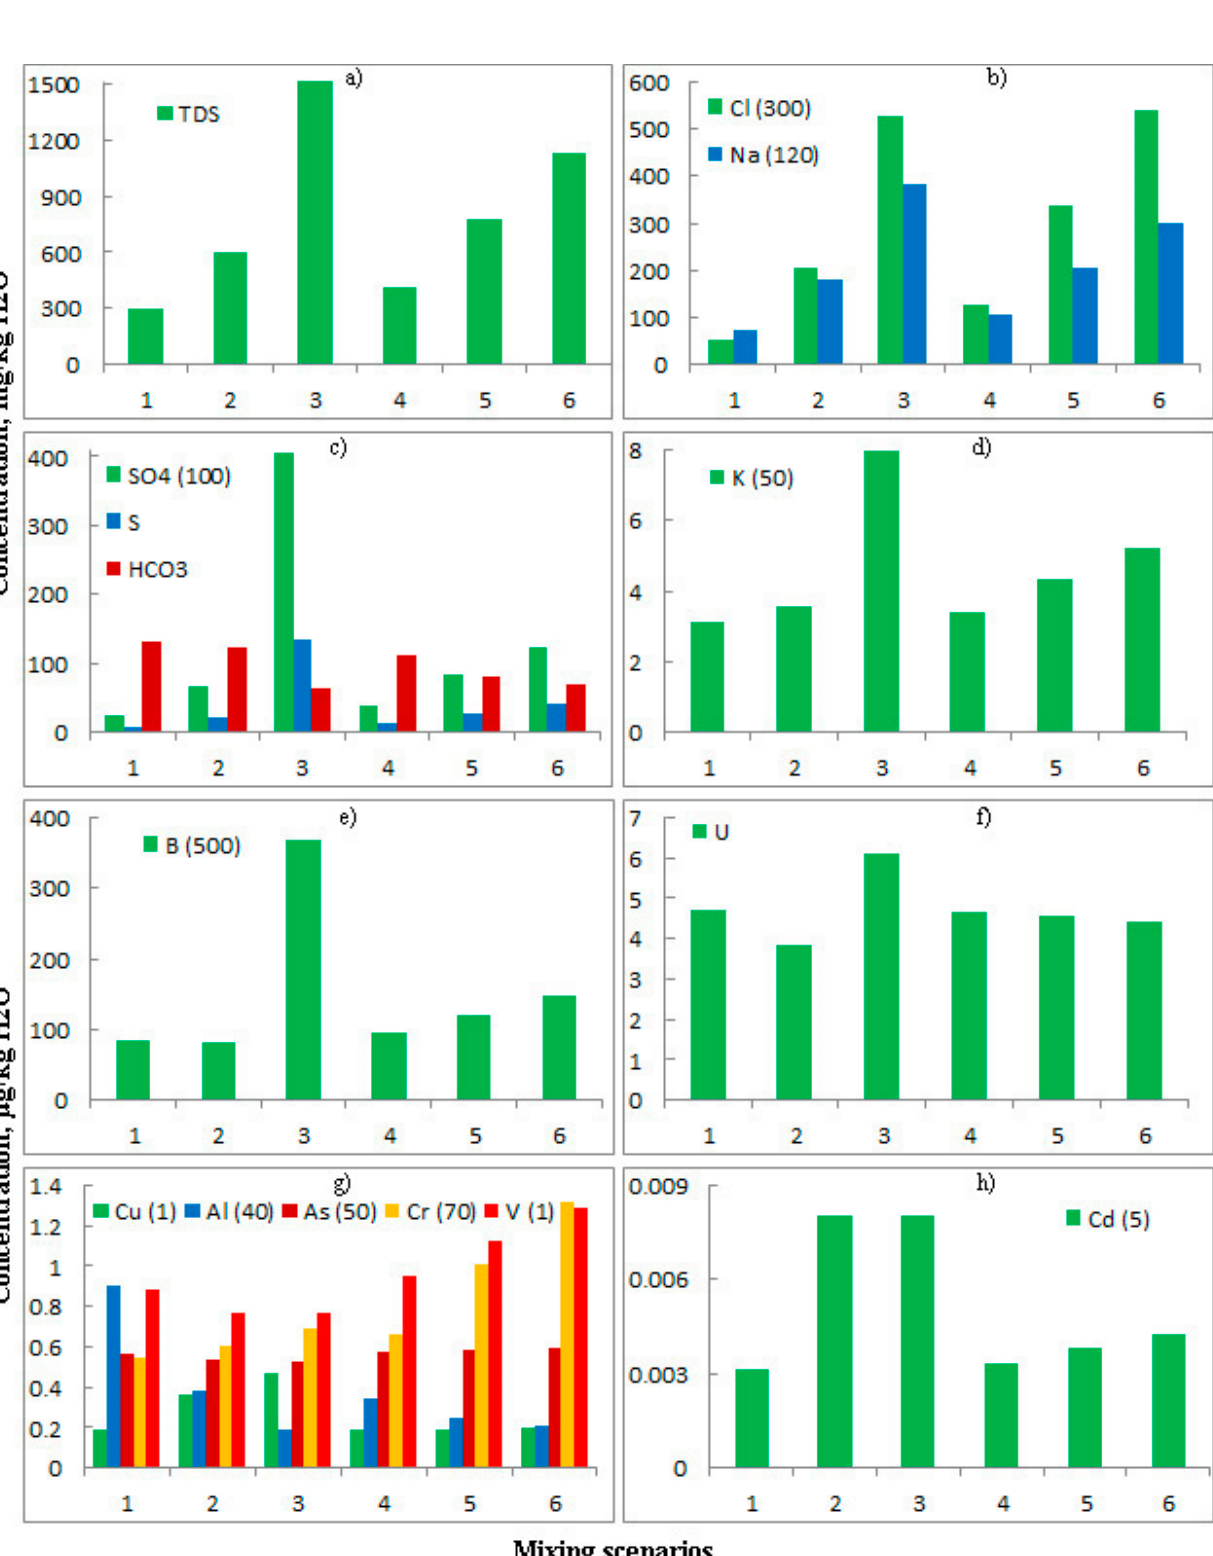
Figure 3. Concentrations of major anions, and major and trace elements in solution: ( a ) TDS; ( b ) Cl − and Na + ; ( c ) SO 4 2 − , S and HCO 3 − ; ( d ) K + ; ( e ) B; ( f ) U; ( g ) Cu, Al, As, Cr and V; ( h ) Cd, calculated as a result of modeling mixing of surface and groundwater according to Scenarios 1–6 (see Tables 2 and 3). MPC values for water bodies used for fishery purposes are given in parentheses next to chemical component symbols.